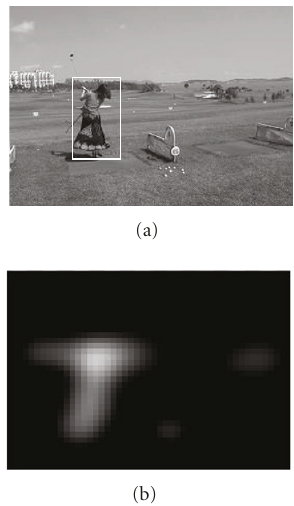
Figure 3: An example of saliency